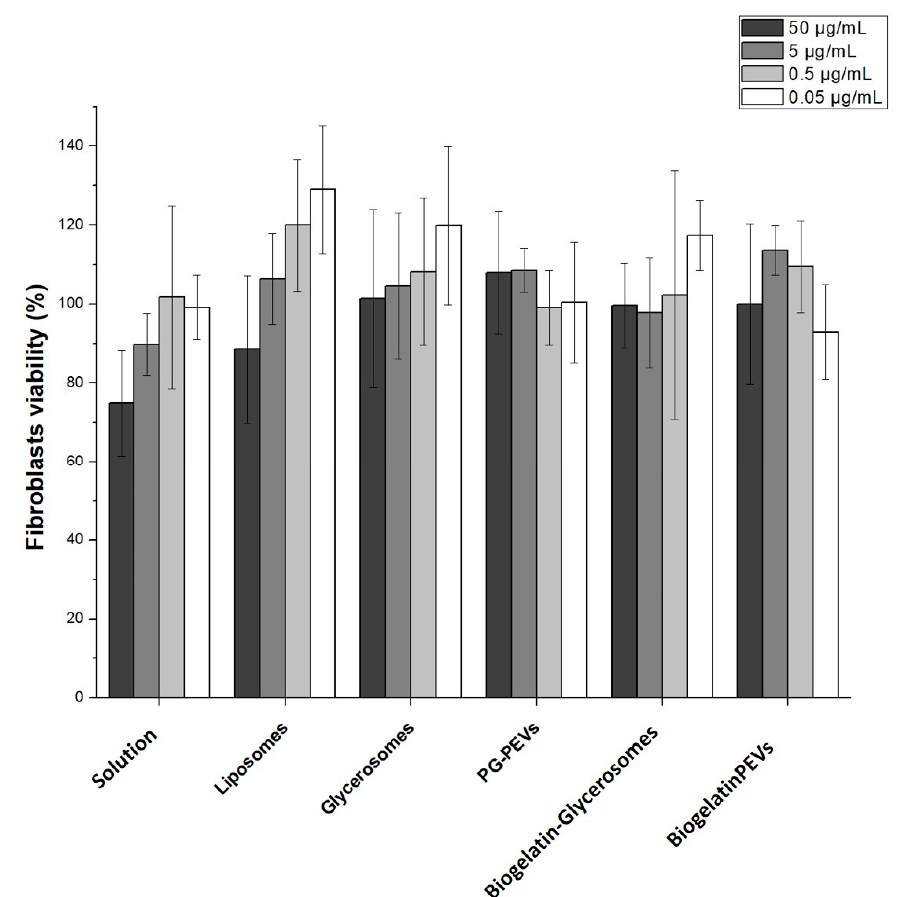
Figure 3. Biocompatibility assay of L. citriodora loaded vesicles performed on fibroblasts.